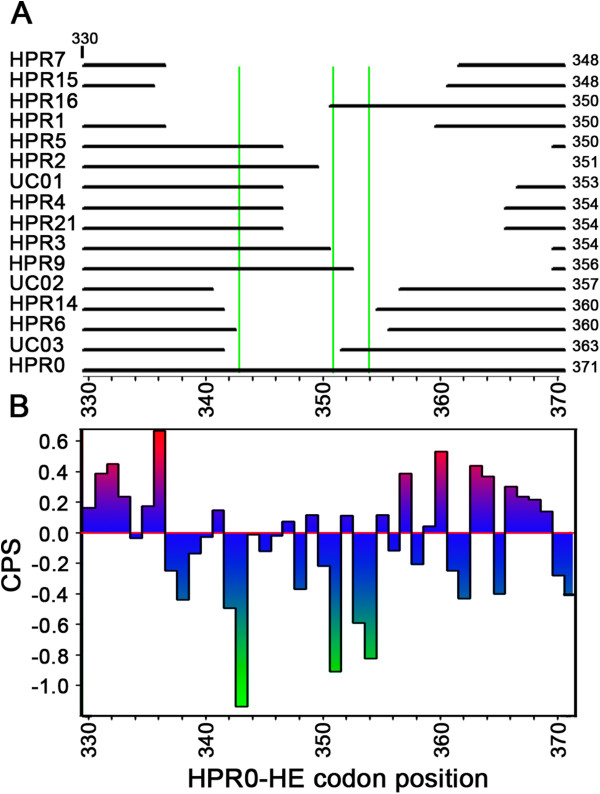
Codon-pair score in the HPR region. The figure shows an alignment scheme among the different HPR in the analyzed HE (Panel A). Panel B shows the codon-pair score (CPS) of the codon pairs in the HPR region of the ISAV HE-HPR0 gene. The green lines identify the codon pairs with lower CPS.